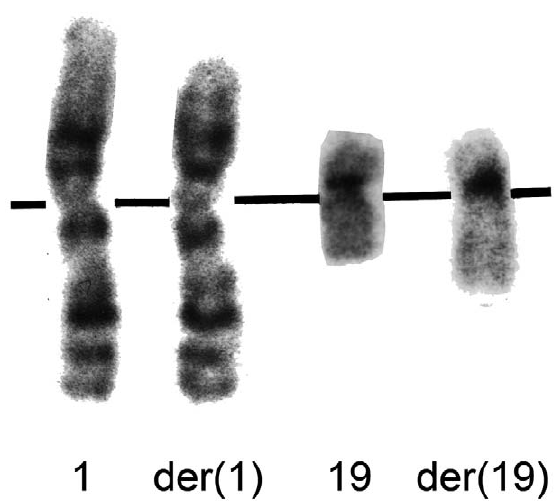
Figure 5. Partial karyotype of cell line S40.2. Partial G-banded karyotype showing chromosome 1 and 19 as well as their derivatives resulting from t(1;19)(p35.2;q13.4).